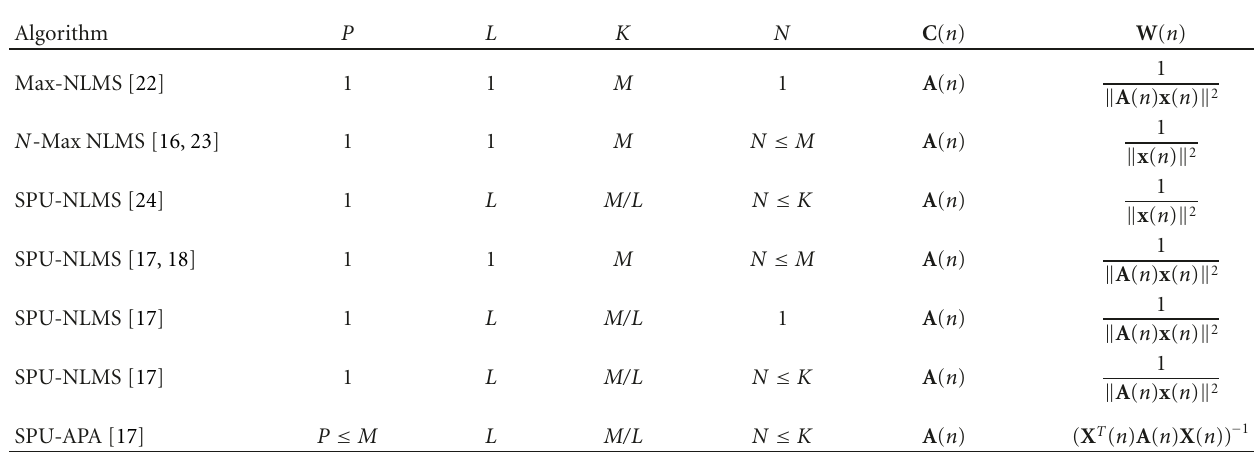
Table 1: Family of adaptive filters with selective partial